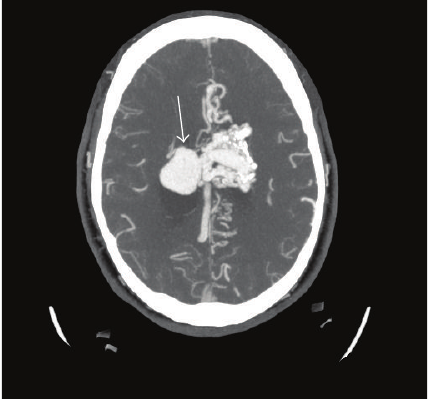
Figure 8: Axial contrast enhanced CTA (MIP) of the brain demon- strating a serpiginous intraventricular enhancing structure (arrow).